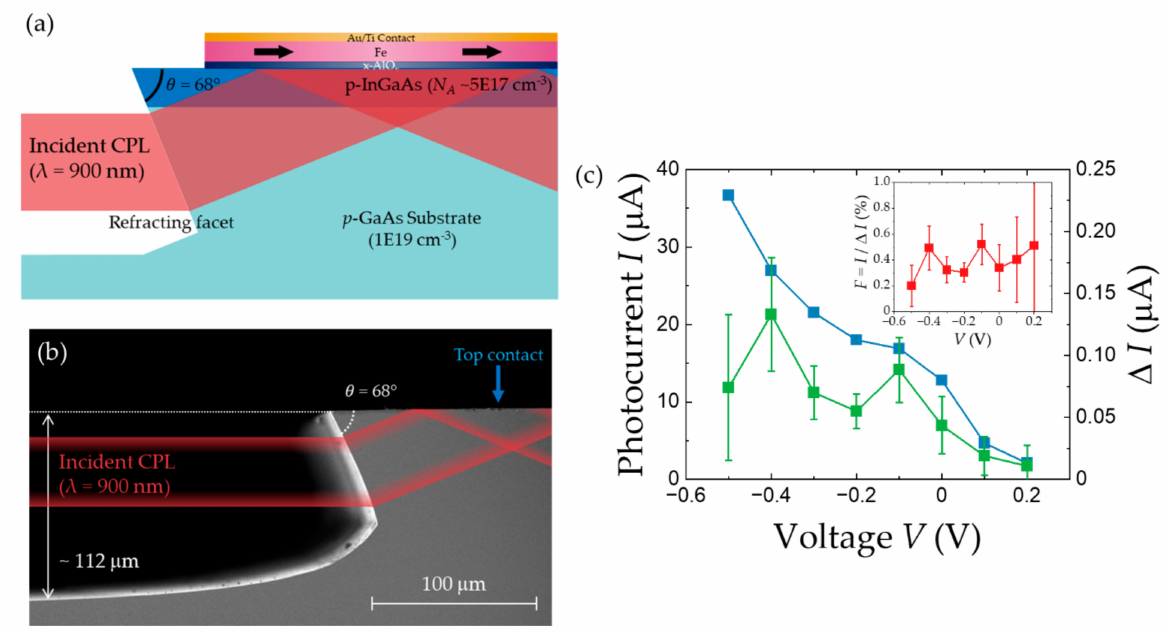
Figure 8. ( a ) Schematic cross–section of a 3G-spin-PD with a refracting facet. The magnetic electrode is located on the mesa structure, and the refracting facet is fabricated outside the stripe-shaped electrode via wet etching. The magnetization direction represented by the arrows in the Fe layer is parallel to the optical axis. A light beam is irradiated horizontally from the left on the refracting facet, bent by the facet, and sent onto the InGaAs active layer. ( b ) Cross-sectional view of the cleaved edge of a fabricated 3G-spin-PD observed by a scanning electron microscope. The facet angle θ is 68 ◦ . The facet height and etch depth are approximately 70 and 110 µ m, respectively. ( c ) Experimental results for a 3G-spin-PD. Plots of the obtained (blue) photocurrent, (green) helicity-dependent photocurrent ( ∆ I ), and (inset) as functions of the applied voltage. Reproduced with permission from